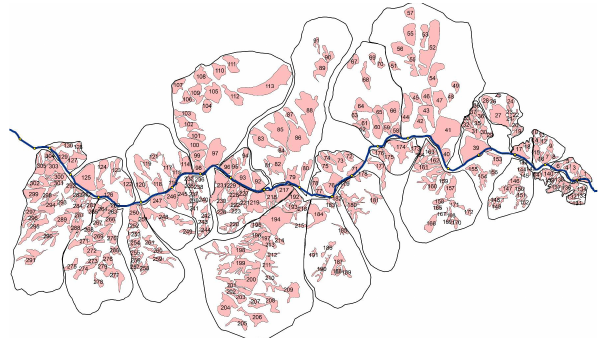
Fig. 7. Distribution of 305 loose deposits between K1 and K18 along PR303.